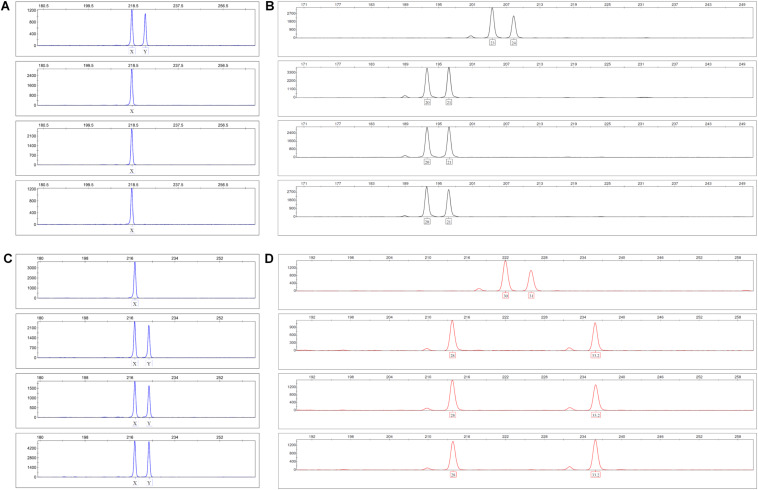
Indel and STR genotypes of post-culture FACS-sorted EC and leukocytes are identical with pre-culture PBMC in fragment analysis. (A,B) Male MSC were co-cultured with female PBMC in 3D fibrin matrices for 1 week. Panel (A) shows the X-Y homologous indel polymorphism in the amelogenin gene and panel (B) the STR polymorphism FGA (4q28) top down: pre-culture MSC, PBMC, post-culture FACS-sorted CD34+CD45- EC and CD34-CD45+ leukocytes. (C,D) Female MSC were co-cultured with male PBMC in 3D fibrin matrices for 1 week. Panel (C) shows the X-Y homologous indel polymorphism in the amelogenin gene and panel (D) the STR polymorphism D21S11 (21q21.1) top down: pre-culture MSC, PBMC, post-culture FACS-sorted CD34+CD45- EC and CD34-CD45+ leukocytes.